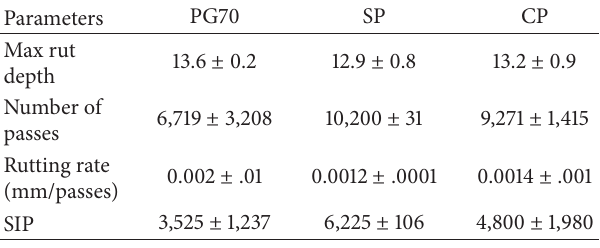
Table 4: Hamburg wheel tracking testing results.